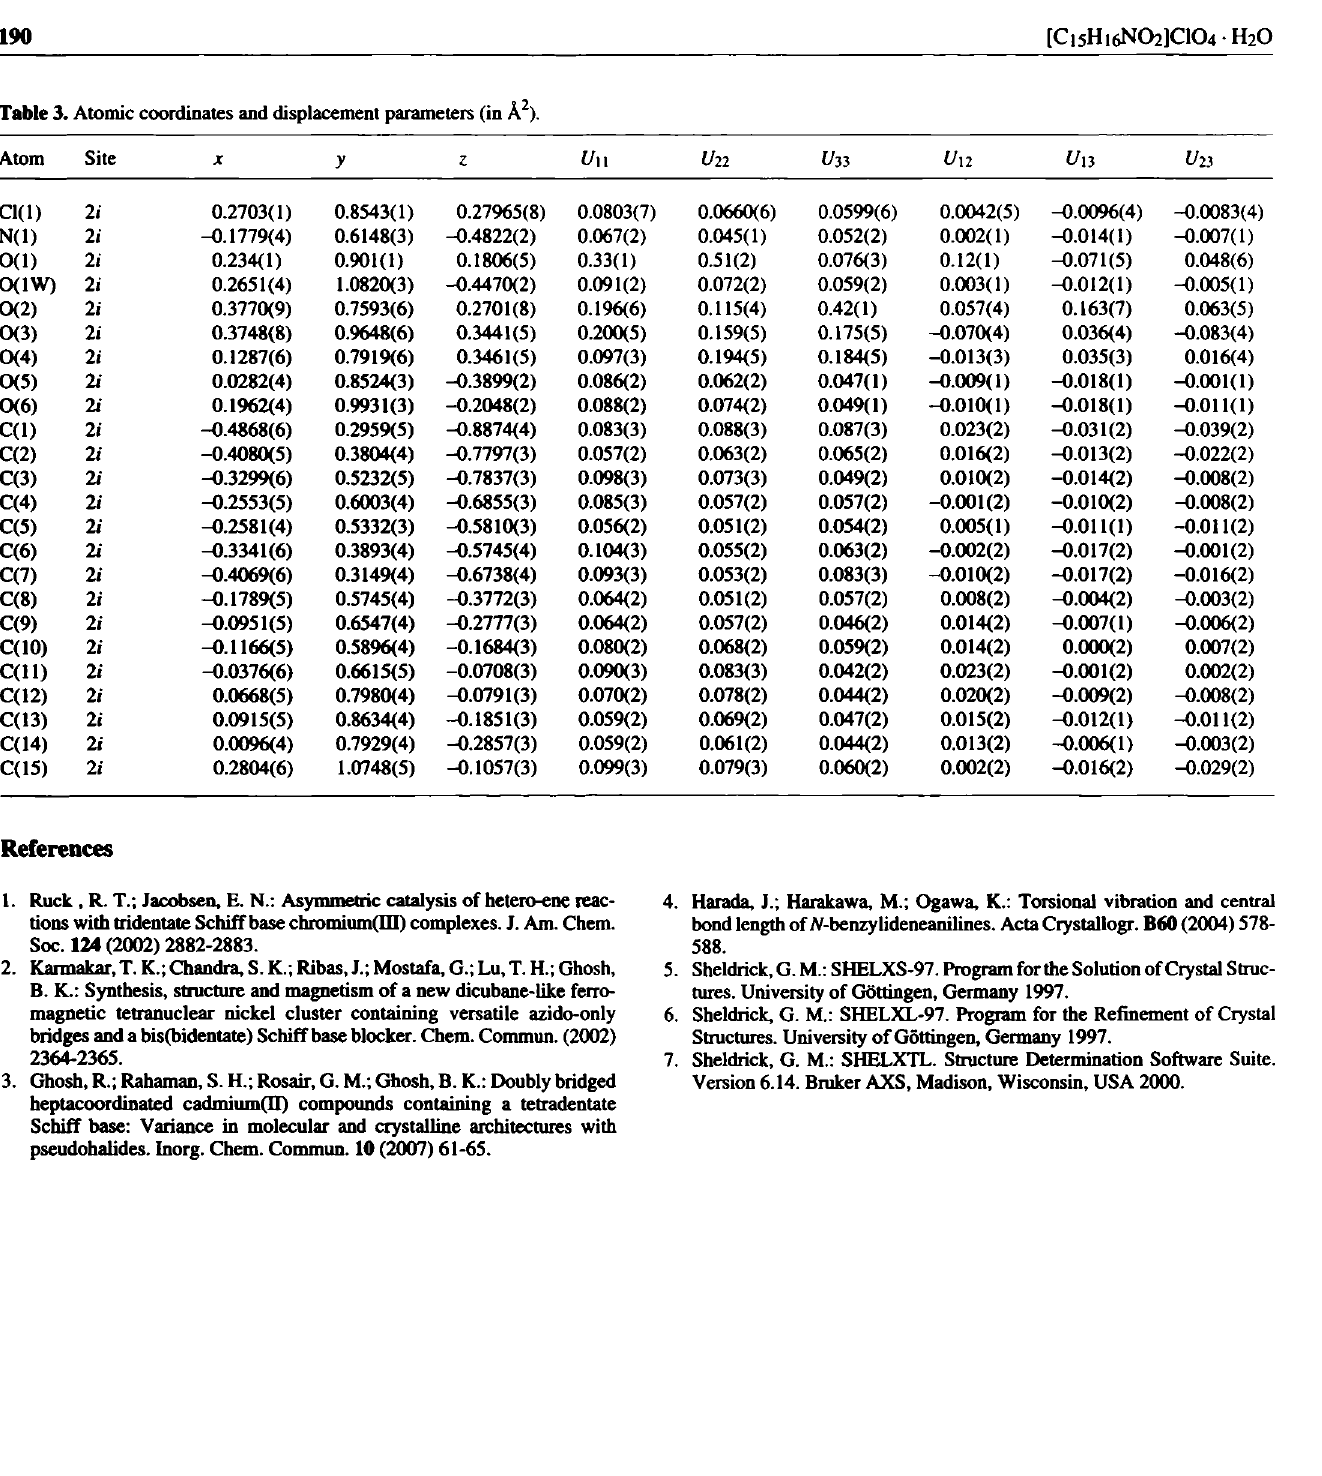
Table 3. Atomic coordinates and displacement parameters (in À 2